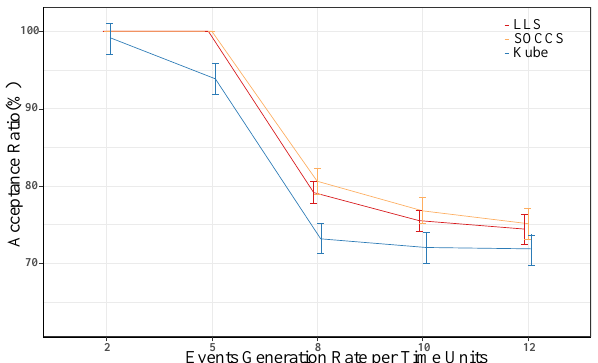
Figure 12. Event acceptance ratio for each scheduling algorithm.